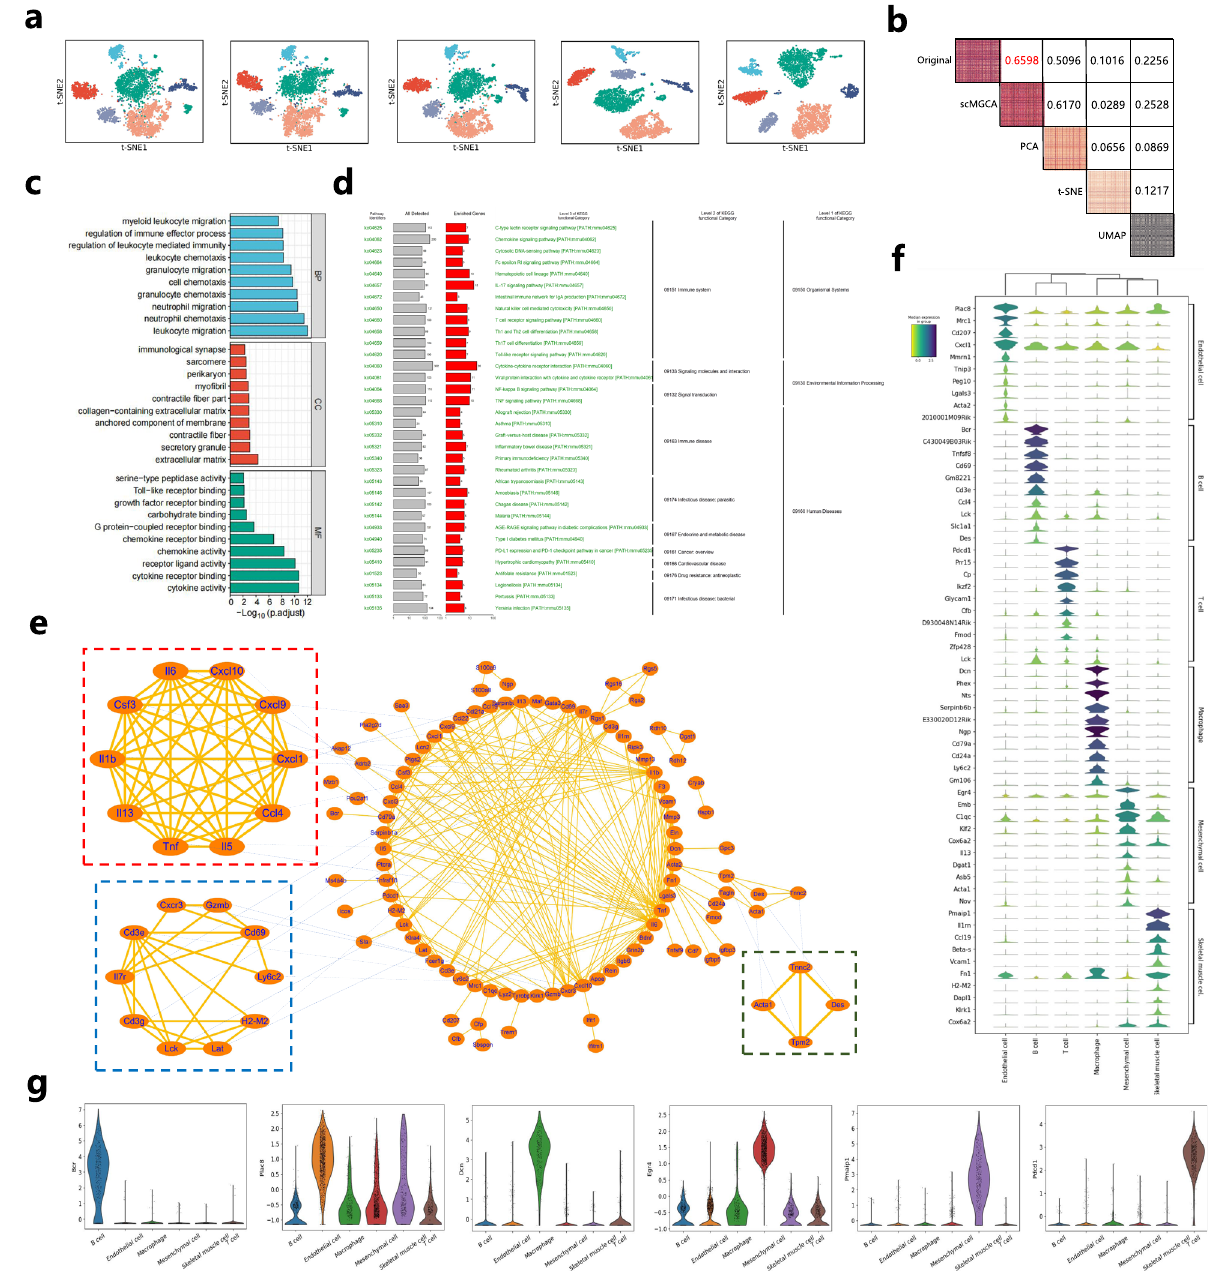
Fig.6|Functionalgenomicsanalysisofthelatentembeddedrepresentationof scMGCA on ‘ Qx Limb Muscle ’ . a 2D-visualization of latent embedded repre- sentations of scMGCA at different training periods using t-SNE. b Cell topology preservation in the latent embedded representation of scMGCA compared with methodsusingPCA,t-SNEandUMAP.TheuppertriangularpartshowsthePearson correlation coef fi cient of the corresponding two spaces, while the diagonal part